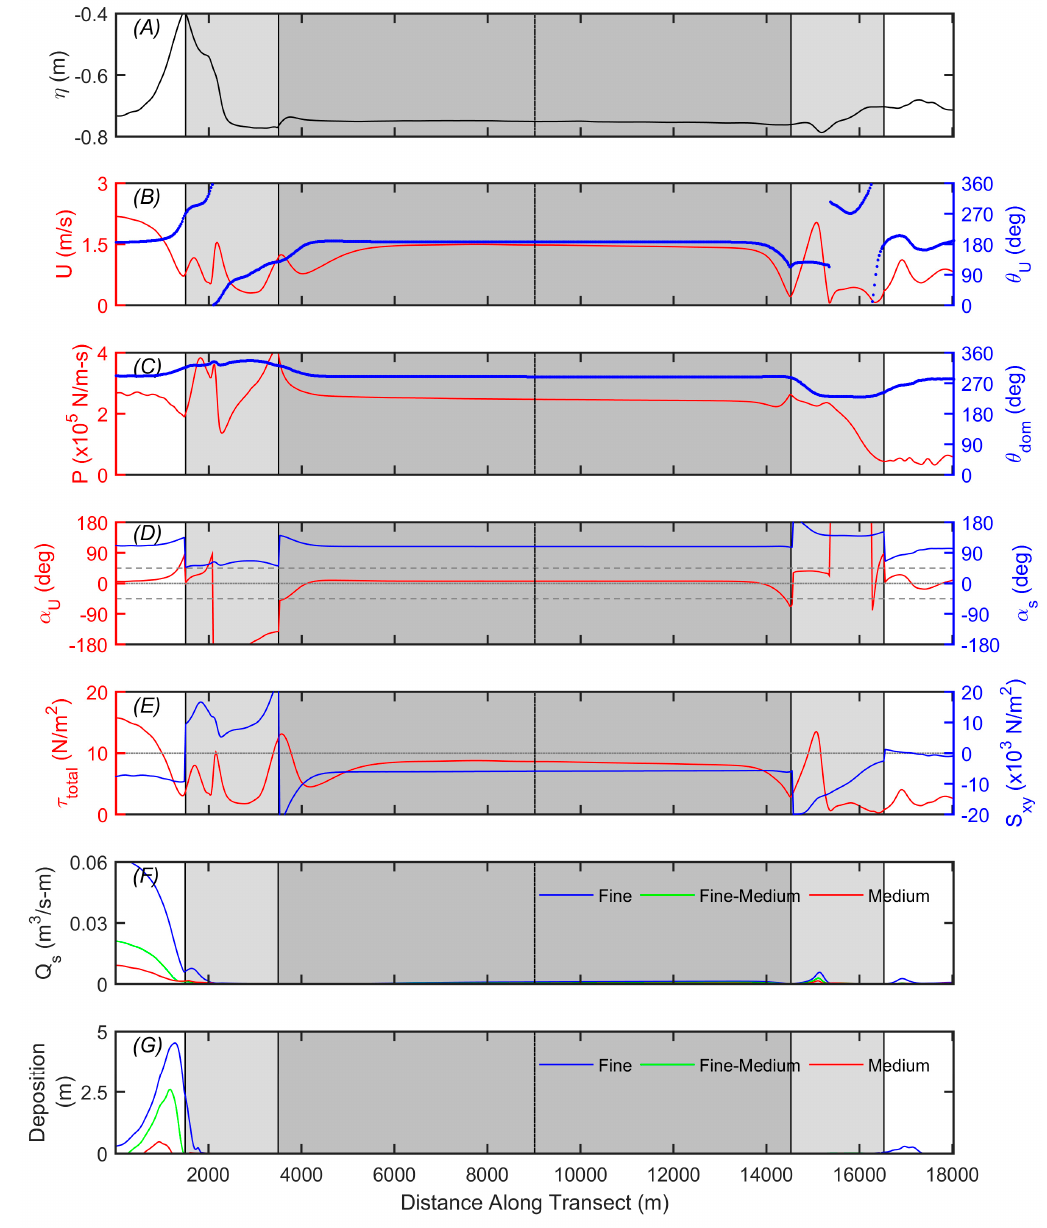
Figure 8. ( a ) Model observations from an alongshore transect 400 m offshore from 25% the length of the headland upstream to downstream during the time ‐ step of fastest velocity. The headland is marked by the gray box and the apex by the dashed line in the center. The dashed lines in panel D indicate 45° and − 45°. Parameters shown are ( A ) water level, ( B ) current speed and direction, ( C ) wave power and wave direction, ( D ) current and wave angle relative to the shoreline, ( E ) total bed shear stress from combined waves and currents and radiation stress from waves, ( F ) total sediment flux for fine (blue), fine–medium (green), and medium (red) sand, and ( G ) total sediment deposition (same colors) for T1. (b ) Same as ( a ) for T6. ( c ) Same as ( a ) for T7. ( d ) Same as ( a ) for T8 with the shore normal faces of the headland noted as the lighter gray boxes.